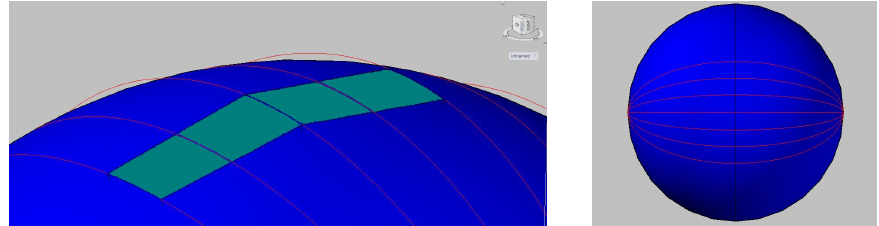
Figure 2: Study of geometry. Approximation of sphere with cylindrical